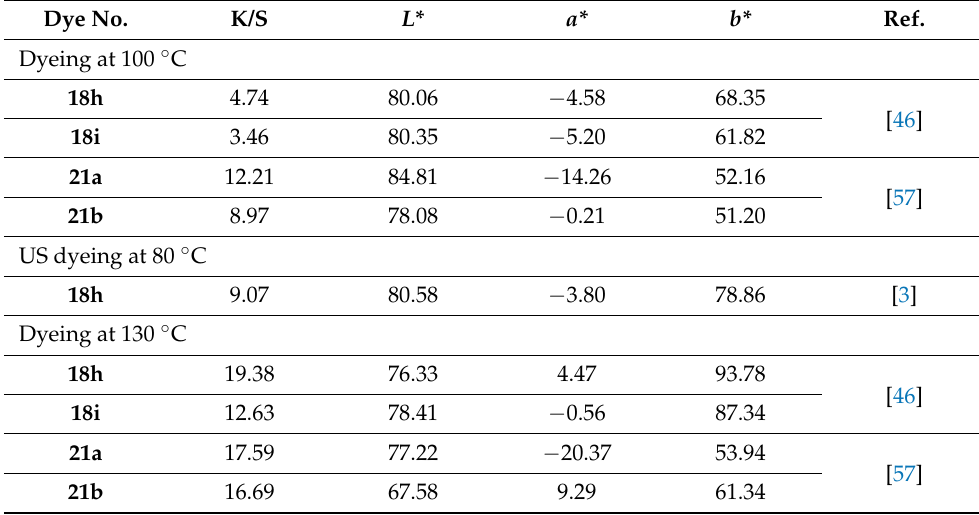
Table 2. Color strengths and colorimetric data of the selected disperse dyes. Dye No. K/S L * a* b*